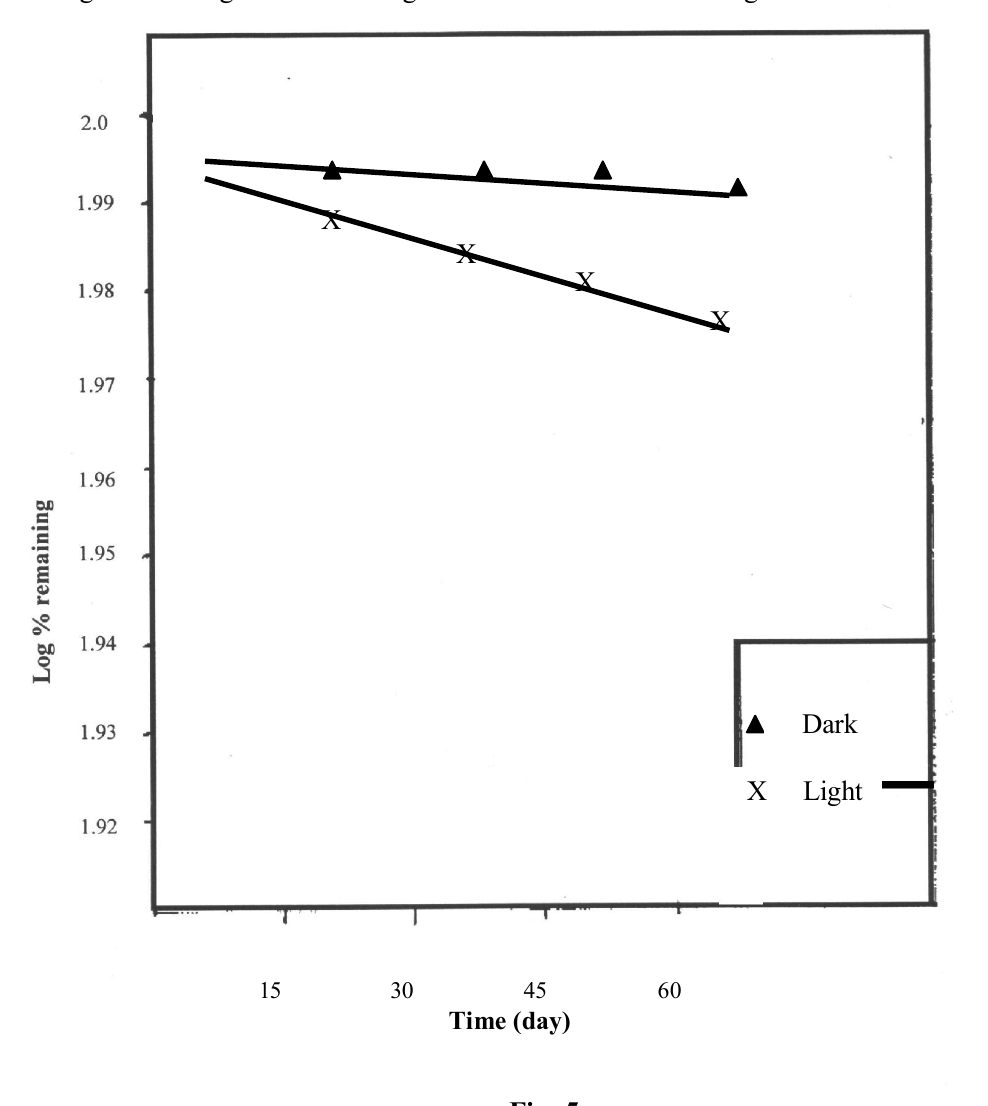
The effect of light on the rate of hydrolysis of Econazole Nitrate in formula E at room